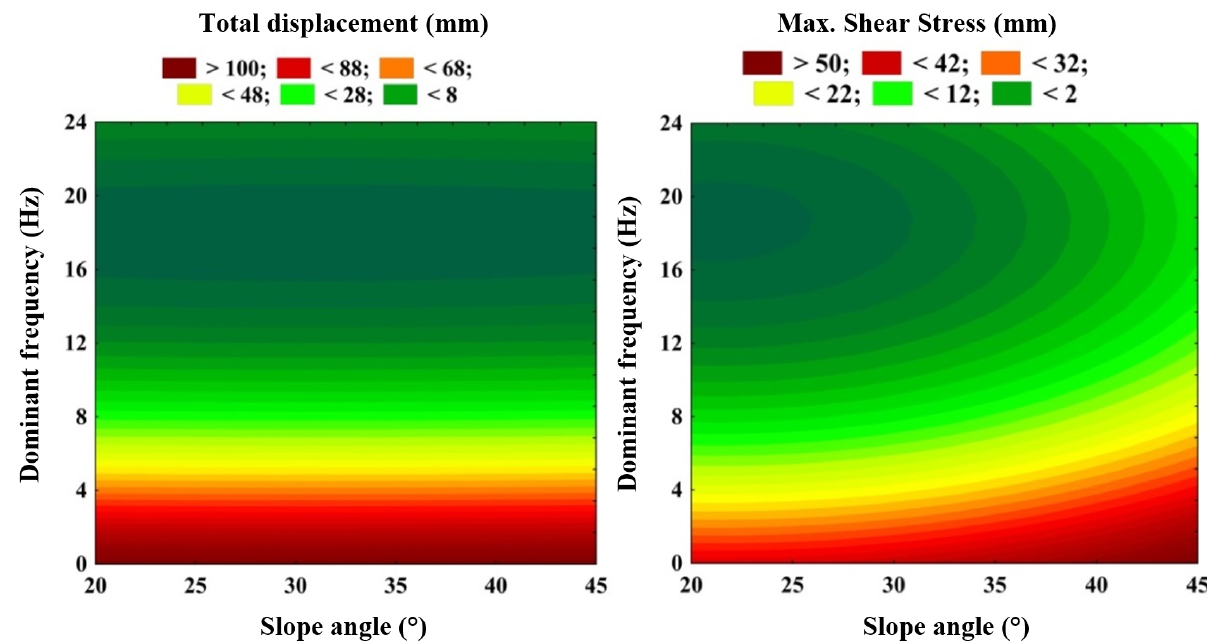
Figure 11: The RSM surface map of the relation between dominant frequency, slope angle and displacement (left) and shear stress (right) for scenarios in which the direction of seismic load is opposite to the direction of slope